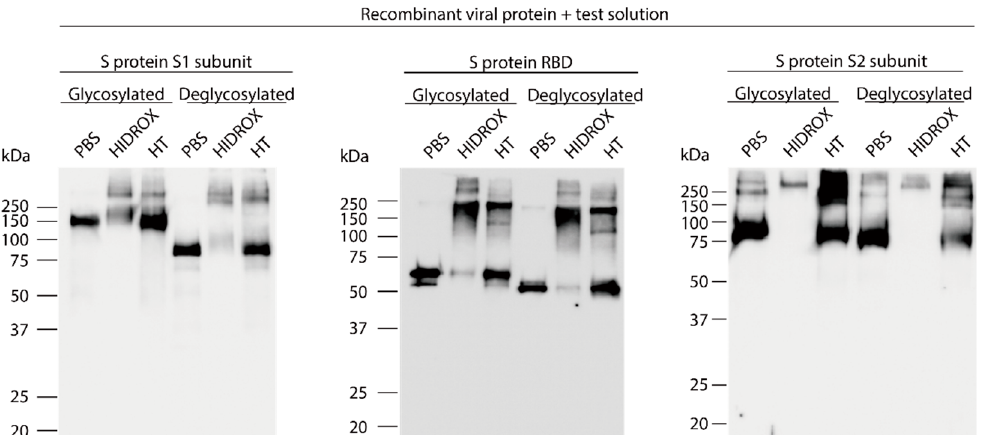
Figure 4. Impact of hydroxytyrosol (HT)-rich aqueous olive pulp extract (HIDROX) or HT on carbohydrate chains expressed on the S protein. The glycosylated or deglycosylated recombinant S protein S1 subunit, RBD, and S2 subunit were mixed with PBS, HIDROX, or HT. The final concentration of HIDROX and HT in the mixture was 0.90 mg/mL. The final concentration of recombinant S proteins in the mixture was approximately 10 µ g/mL. The mixtures were incubated at 25 ◦ C for 24 h and then Western blotting was performed. The images on the left, middle, and right show the S1 subunit, RBD, and S2 subunit, respectively.